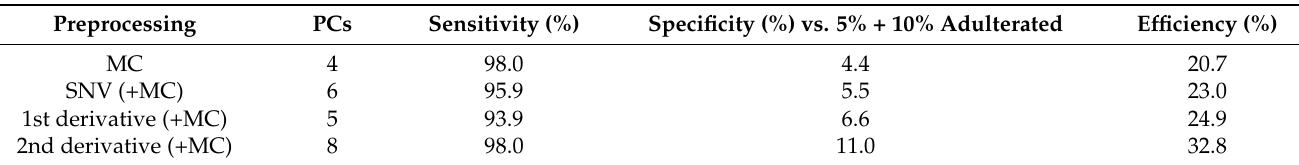
Table 3. Soft independent modeling of class analogies (SIMCA) modeling of the authentic class (49 training samples): results of cross-validation for model